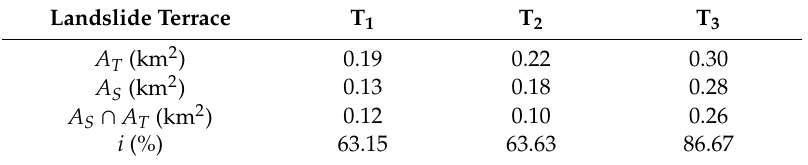
Figure 12. Geomorphological features of the Xinpu landslide based on slope unit extraction: ( a ) front view and ( b ) lateral view of slope units from the MIA-HSU method; ( c ) front view and ( d ) lateral view of slope units from the conventional method. Note that the three landslide terraces shown in Figure 6 (T 1 , T 2 , and T 3 ) were extracted using the MIA-HSU method, which is not the case for the conventional method. Table 5. Area overlap degree of area of slope unit and landslide terraces 1–3 of the Xinpu landslide.